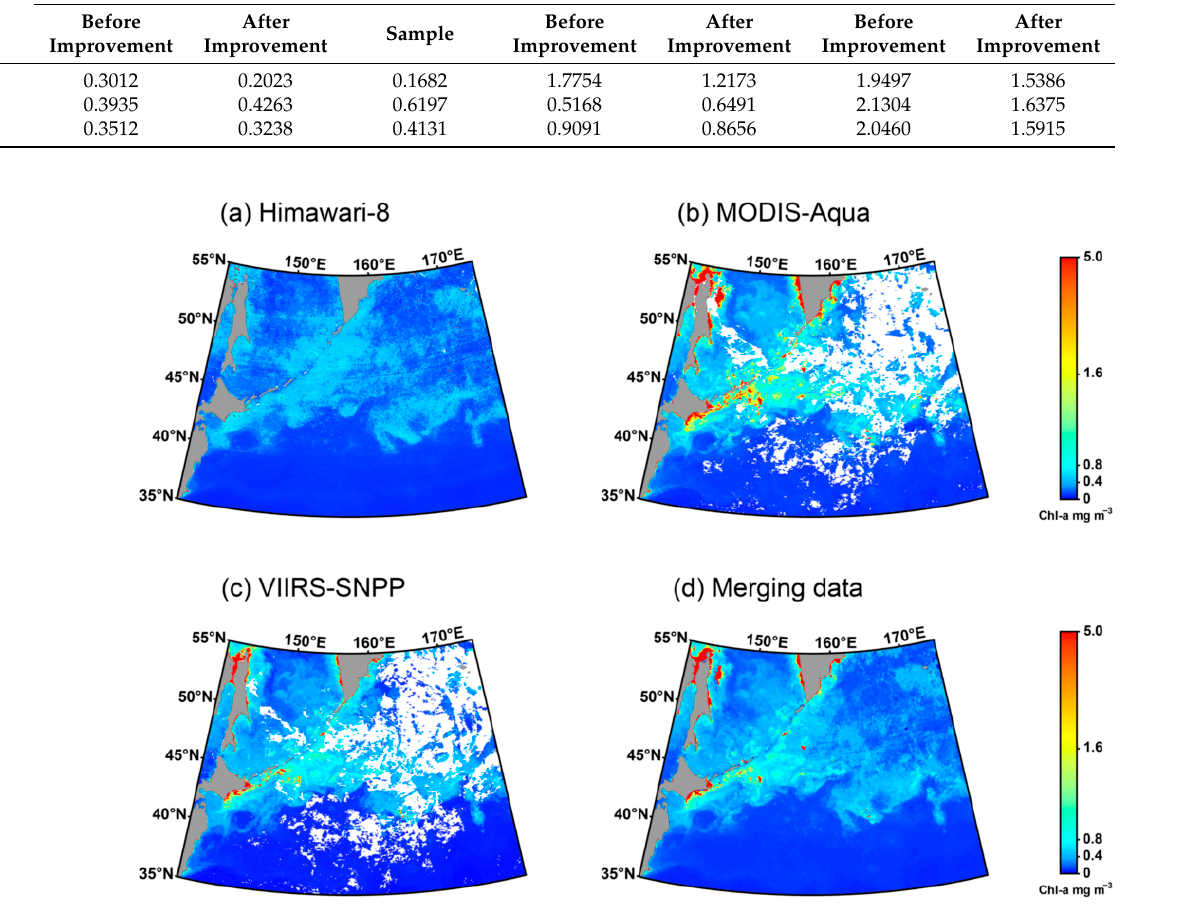
Figure 11. Comparison of single-sensor monthly data and monthly merged data based on blending algorithms. The data are the August 2019 monthly data of the three sensors.